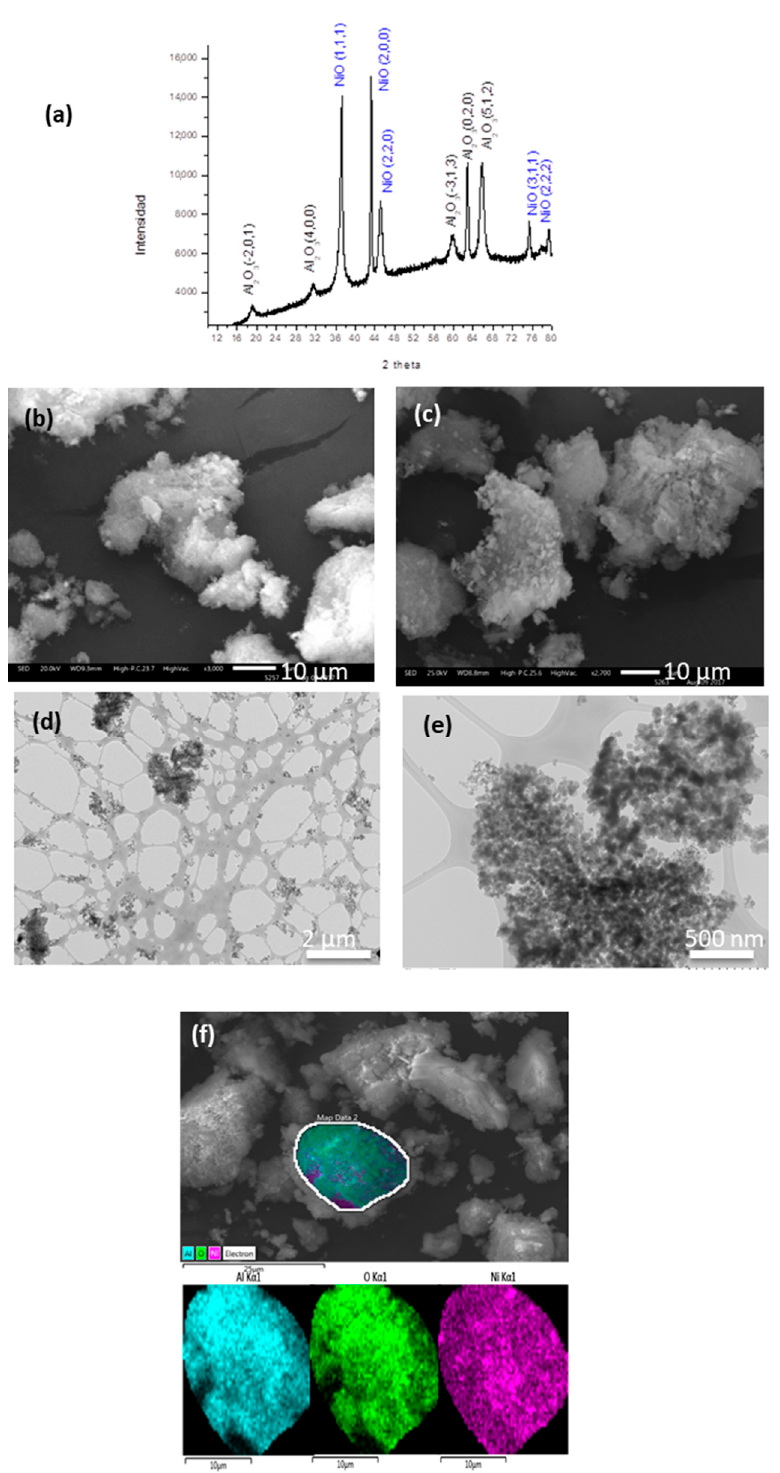
Figure 4. ( a ) XRD pattern of NiO/Al 2 O 3 from the chitosan precursor; ( b ) SEM image of NiO from chitosan and ( c ) from PVP; ( d ) TEM image of NiO from chitosan and ( e ) from PVP; ( f ) EDS mapping of NiO from chitosan.